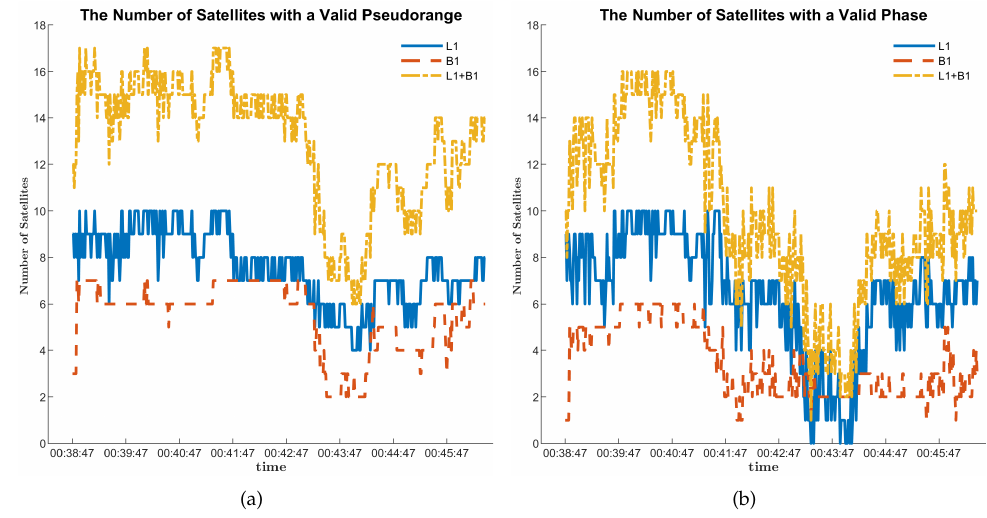
Figure 11. The number of the visible satellites with a valid pseudo-range and the number of the visible satellites with a valid carrier phase at different moments. ( a ) The number of the visible satellites with a valid pseudo-range at different moments. ( b ) The number of the visible satellites with a valid carrier phase at different moments.